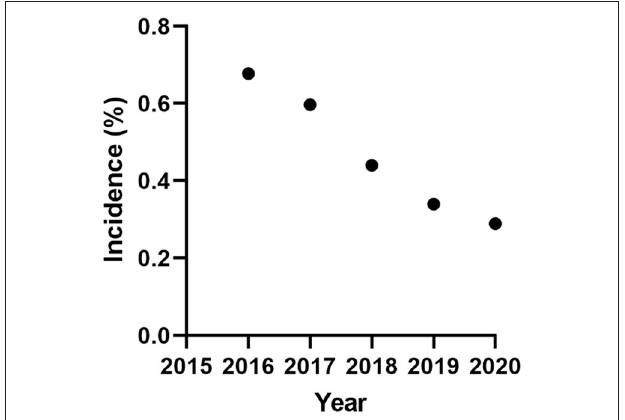
FIGURE 2 | The annual incidence of animals disclosing as BVDv positive on the basis of their most recent test result.